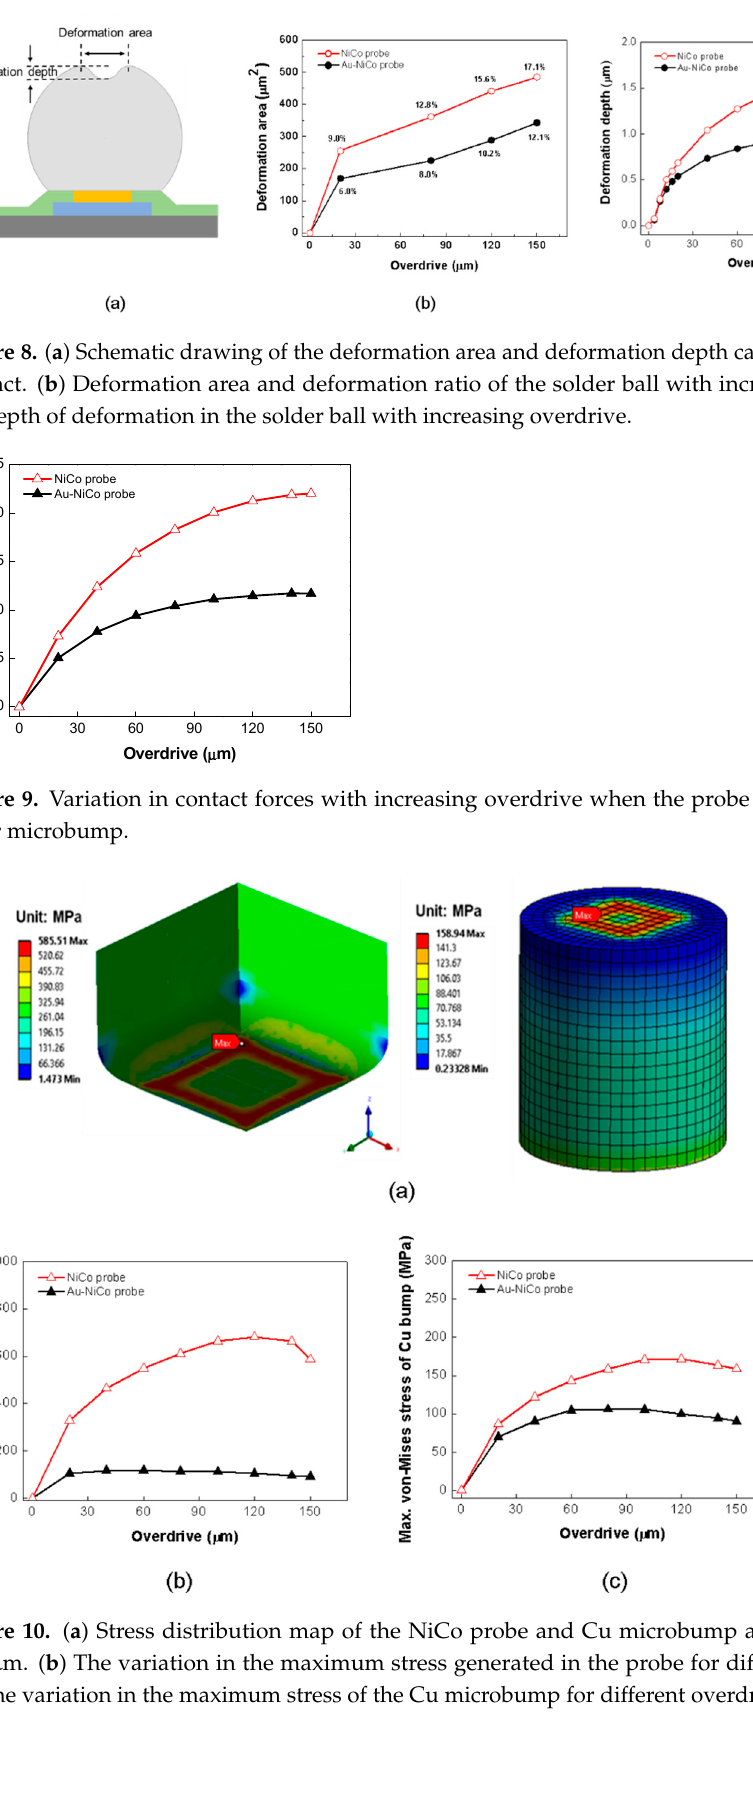
Figure 11. The variation in the contact forces with different overdrives for the TSV structure. Figure 12a shows the von Mises stress distribution generated in the Cu via of the TSV structures using the NiCo probe at an overdrive of 150 µm. Figure 12b,c show the varia- tion in the maximum stress generated in the Cu via and probe, respectively, with increas- ing overdrive. The trend in stress variation was also similar to the case with the Cu pillar microbump. However, the stress level in the TSV was much higher than with the Cu pillar microbump. Unlike the Cu pillar microbump, the Cu via in the TSV was surrounded by a stiff SiO 2 layer and Si wafer, and the lateral deformation of the Cu via was restricted by these materials during the probe contact. As a result, the Cu via was subjected to a higher stress than the Cu pillar microbump. The maximum stress in the Cu via was 233 MPa at